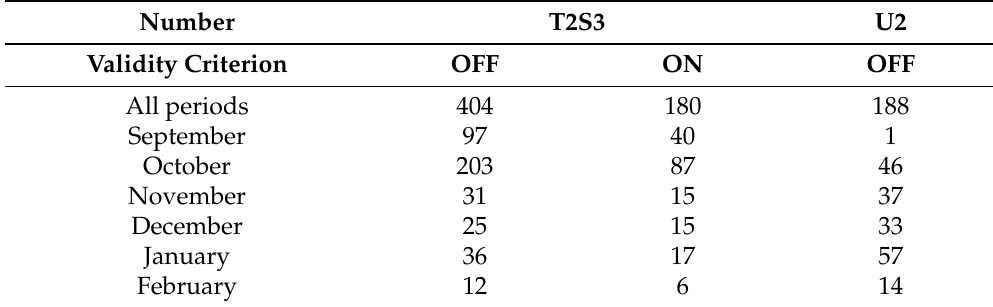
Table 1. Number of